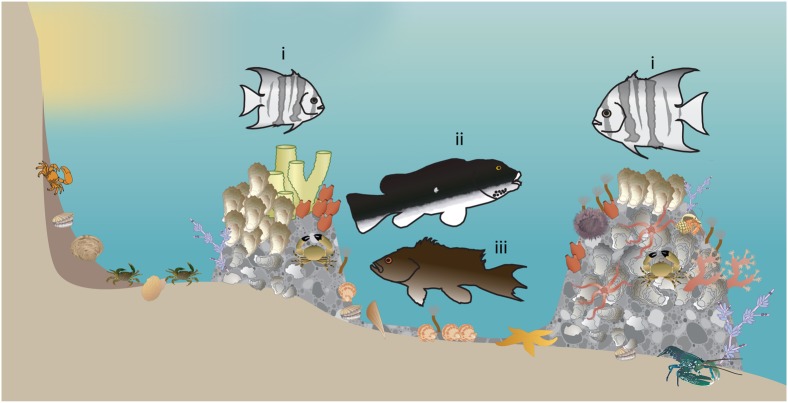
Conceptual diagram of the microhabitat specialization of the three mid-Atlantic temperate reef fishes examined in this study.Spadefish (i) are predators of cnidarians, bivalves, and small crustaceans, often schooling in large numbers above hardbottom habitats, shipwrecks, and marine construction platforms (Hayse, 1990). Tautog (ii) are predators of mollusks and crustaceans, demonstrate strong association with natural and manmade structures, and undertake seasonal inshore-offshore movements induced by temperature changes (Olla et al., 1974; Olla et al., 1980; Auster, 1989; Clark et al., 2006). Black sea bass (iii) are structure-associated predators of a myriad of crustaceans, bivalves, and small to medium-sized fishes (Steimle and Figley, 1996). Juveniles of these three species use estuarine waters as nursery and foraging grounds. Invertebrate symbols are courtesy of the Integration and Application Network, University of Maryland Center for Environmental Science (http://ian.umces.edu/symbols).